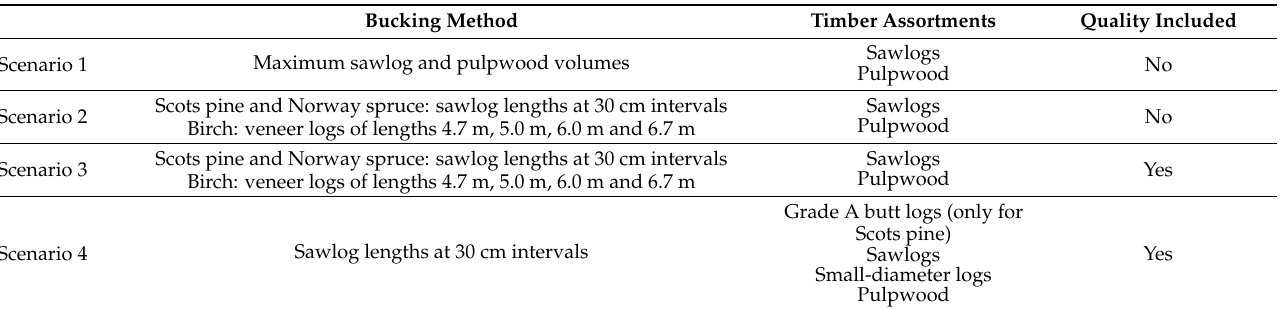
Table 2. Distinctions between the calculation scenarios. Bucking Method Timber Assortments Quality